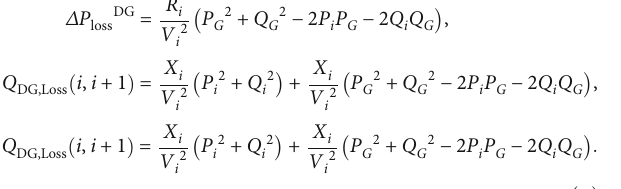
Figure 5: Modeling grid-tied